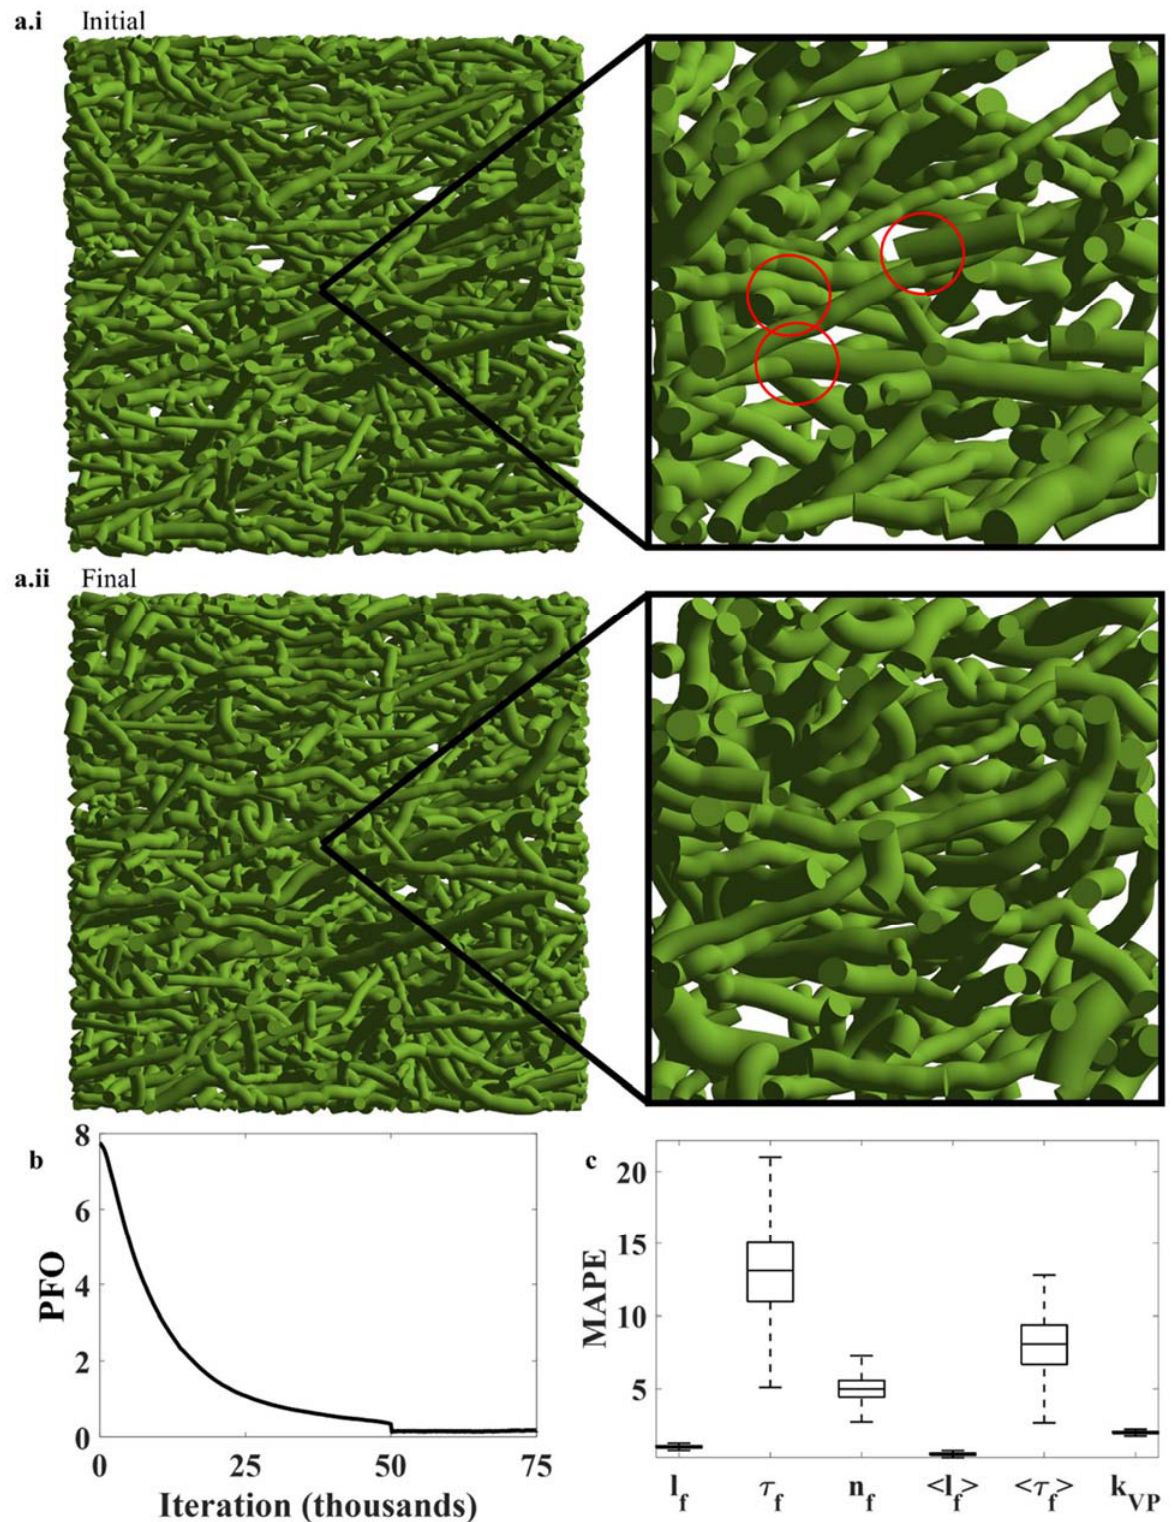
Figure 4. The effects of enforcing non-penetration conditions: ( a.i , a.ii ) An FM model before and after enforcing non-penetration conditions. ( b ) Percent fiber overlap (PFO) during the simulation. ( c ) Statistical characterization of mean absolute percentage error between the initial and final fiber lengths, tortuosities, and orientations .